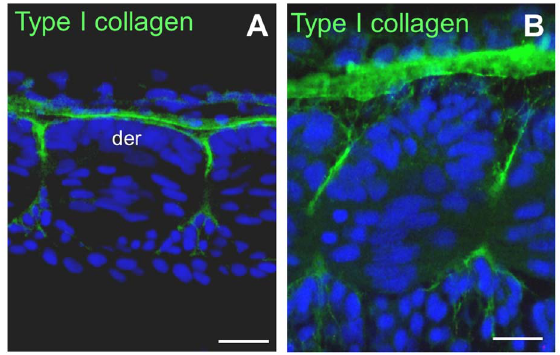
Figure 1. Collagen I is concentrated at the surface of the somites. ( A and B ) Frontal sections through the trunk of a 13 dpf trout embryo. ( A ) Posterior tail. Collagen I immunofluorescence localises to the anterior and posterior edges and at the lateral surface of the dermomyotome. ( B ) Anterior tail. Collagen I immunofluorescence is present along the space separating adjacent somites. der: dermomyo- tome. Scale bars in A and B, 15 m m.